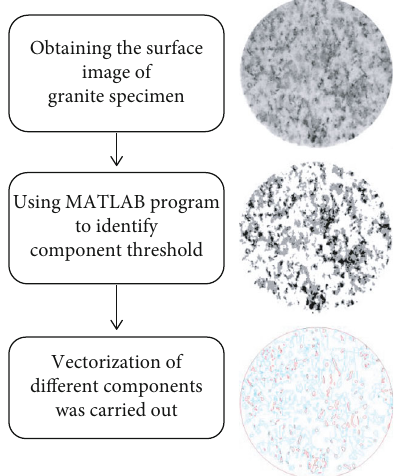
Figure 3: Acquisition process of the component position structure of the test piece.